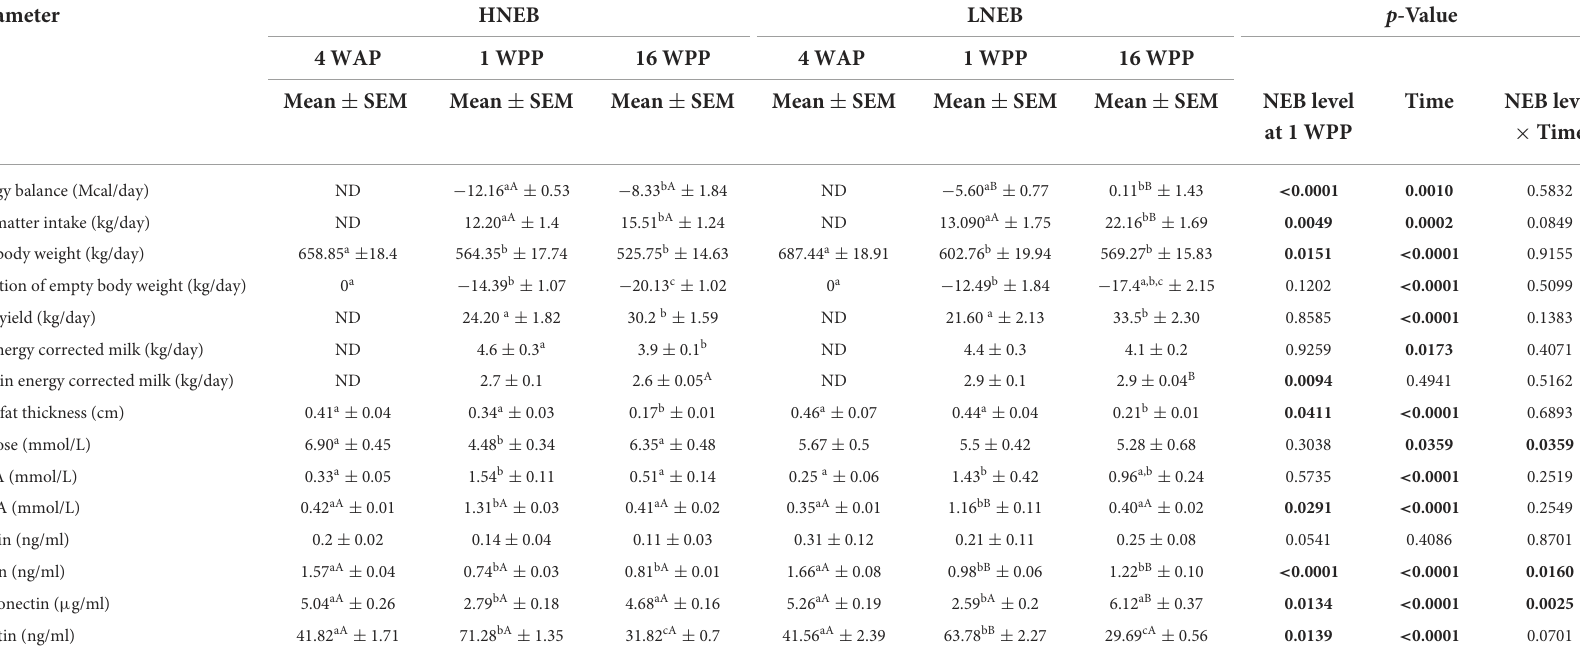
TABLE 1 Zootechnical parameters and plasma metabolites and hormonal concentrations in the high negative energy balance (HNEB, n = 13) and low negative energy balance (LNEB, n = 8) dairy cow groups 1 at 4 WAP, 1 WPP and 16 WPP.